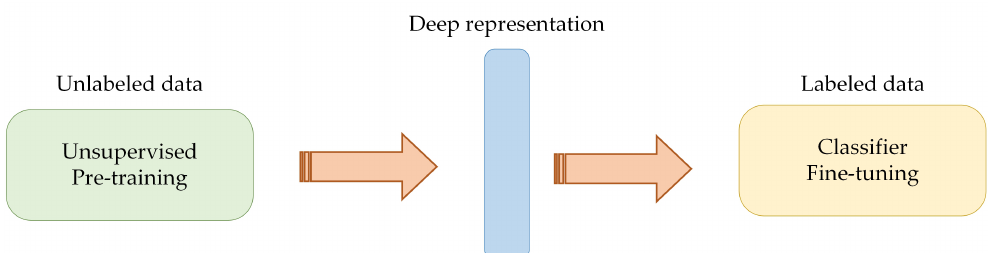
Figure 3. General flow chart of the training of